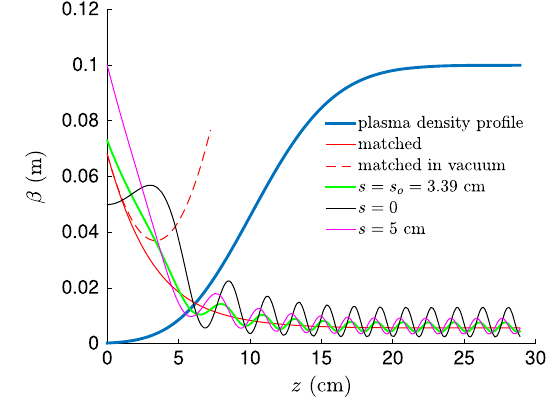
FIG. 5. The evolution of β for the witness beam for different s from numerical calculation. The plasma density profile is in arbitrary units.